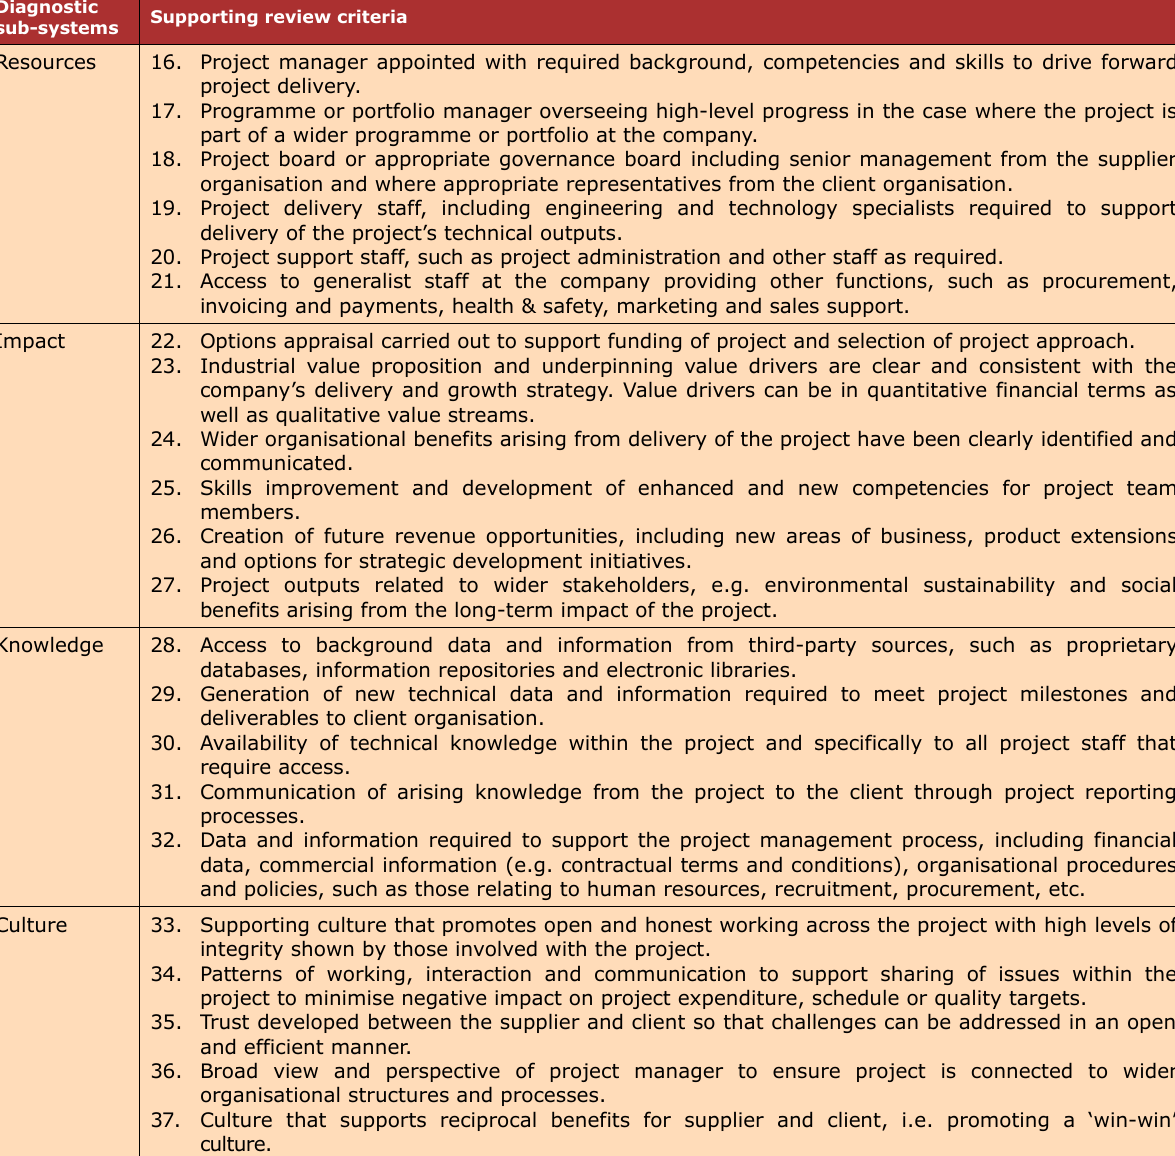
Table 2. Diagnostic framework for project health checks including supporting review